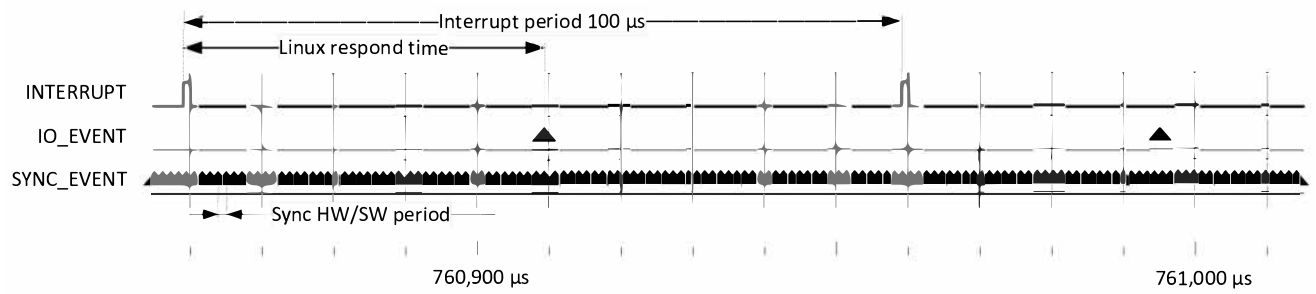
Figure 13. Co-simulation frame showing physical and virtual interactions. Example of the number of IO and synchronization events for each interrupt at 40 KB/s IO rate.